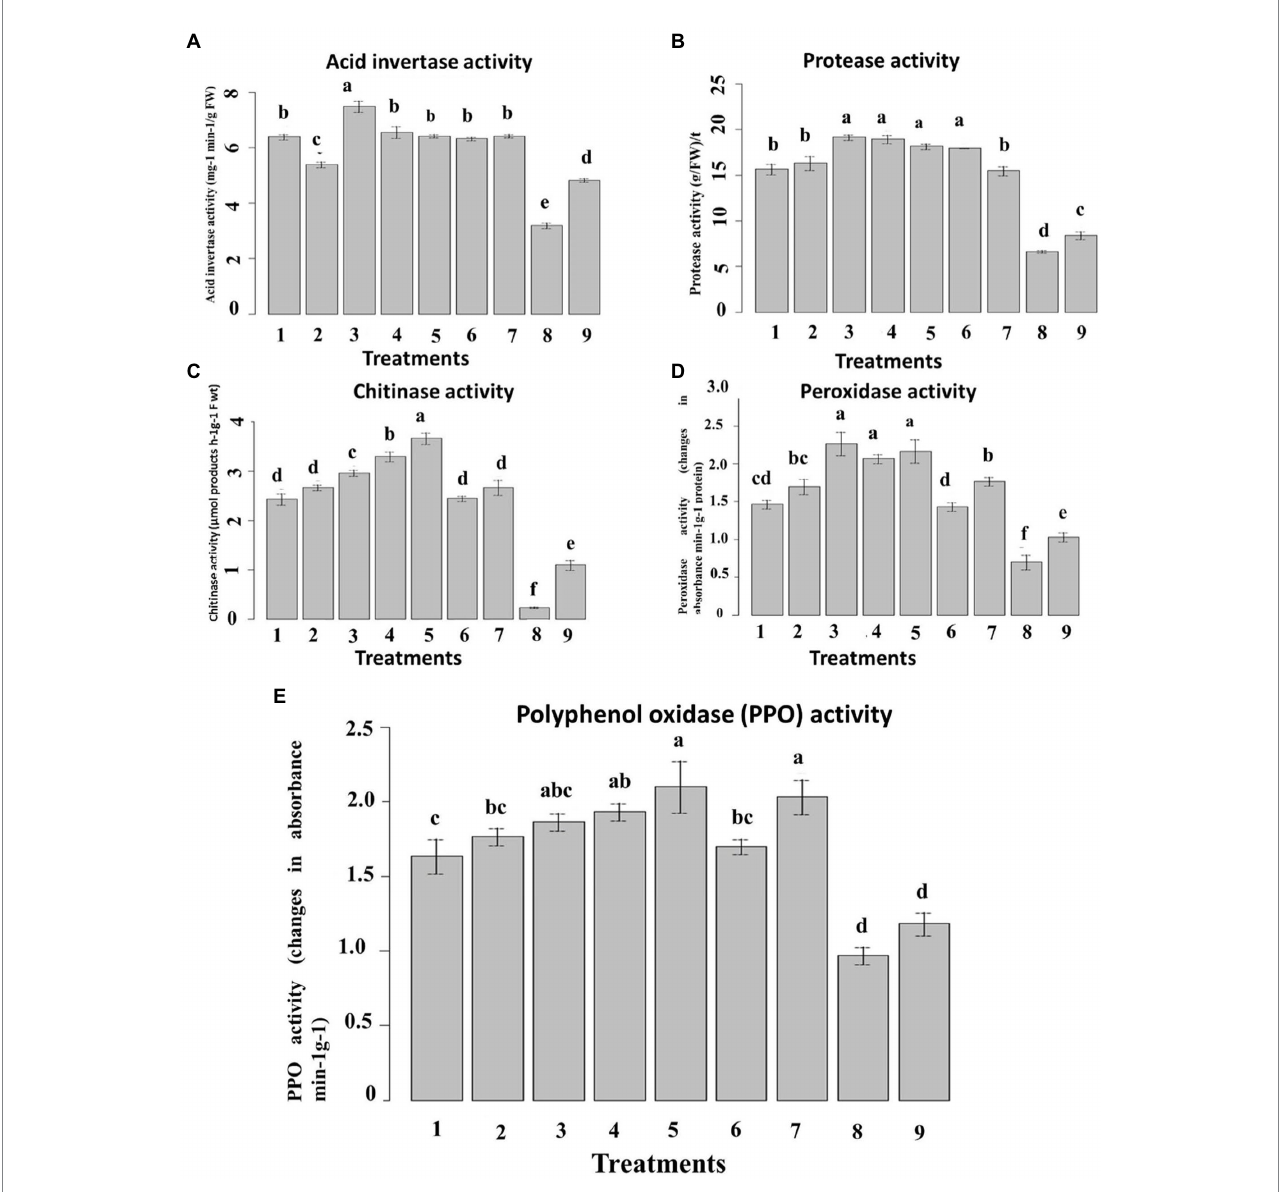
FIGURE 11 Effect of six nanoemulsions treatments on defense-related enzyme and pathogenesis-related proteins in maize leaves: (A) acid invertase activity (IA), (B) protease activity, (C) chitinase activity, (D) peroxidase activity, and (E) polyphenol oxidase (PPO): 1–6 are 0_T80, 5_T80, 10_T80, 0_T20, 5_T20, and 10_T20, respectively. 7–9 are chemical fungicide, untreated control, and infected control, respectively. Values marked with the same letters are not statistically different according to post hoc test DMRT at p ≤